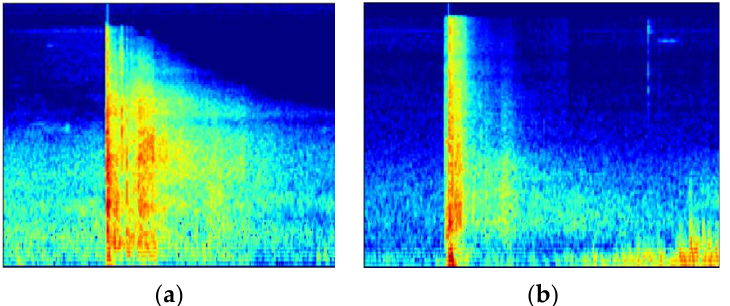
Figure 6. Log-mel spectrogram of AK-47 gun sound in ( a ) YouTube gunshots dataset ( b ) NIJ Grant gunshots dataset.